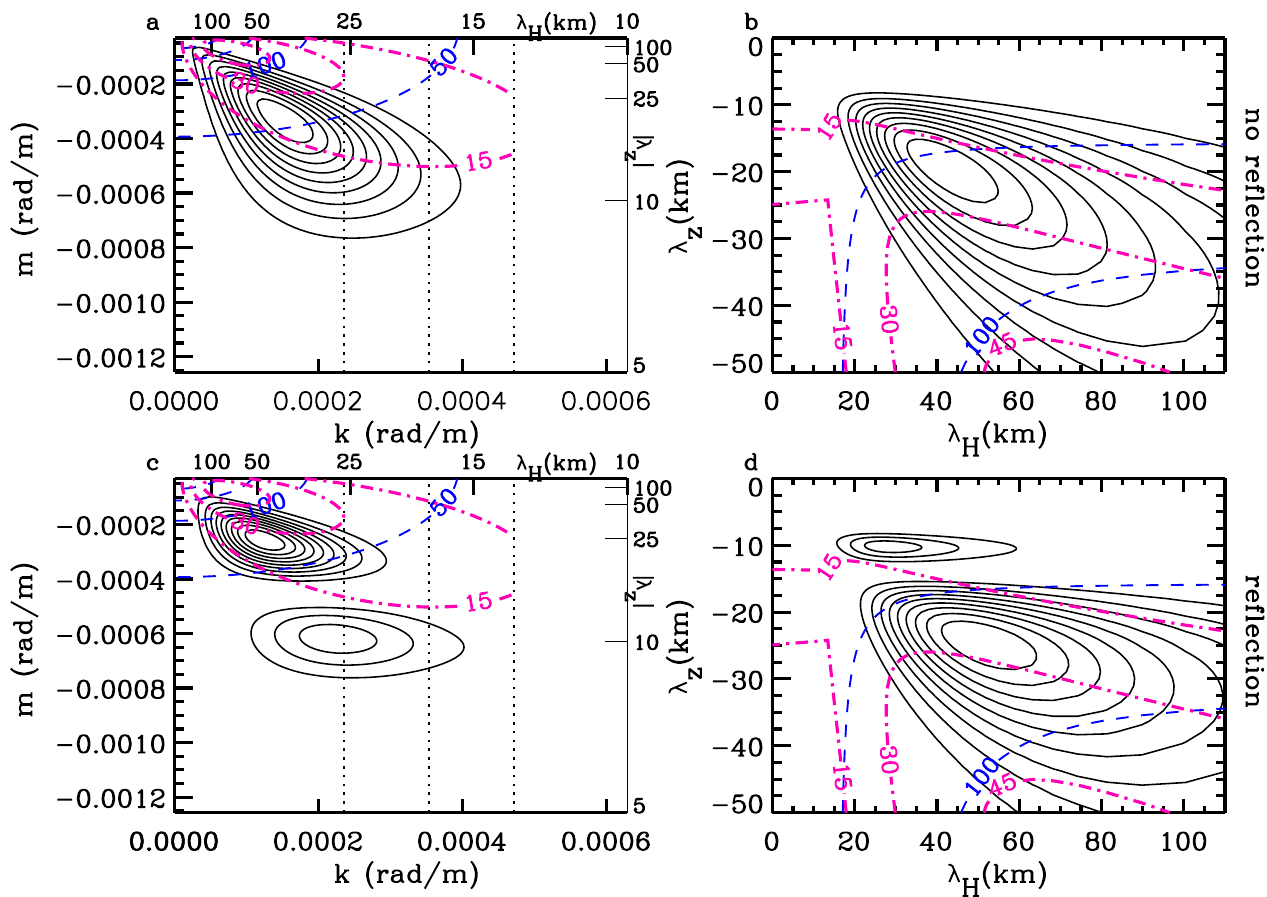
Fig. 2. Vertical flux of zonal momentum in the form given by Eq. (35) as a function of horizontal and vertical wavenumbers (left column) and wavelengths (right column) for upward and eastward-propagating GWs (solid lines) excited from a single convective plume. Upper row: No ground reflection. Lower row: Ground reflection included. Contours show 10% intervals of the maximum value. Pink dash-dot lines indicate c gz in intervals of 15m / s. Blue dash lines indicate c H in intervals of 50m / s. Dotted lines in (a) and (c) show λ H = 13 . 3, 17 . 8km, and 26 . 6km. The resolution is 1x = 6 .